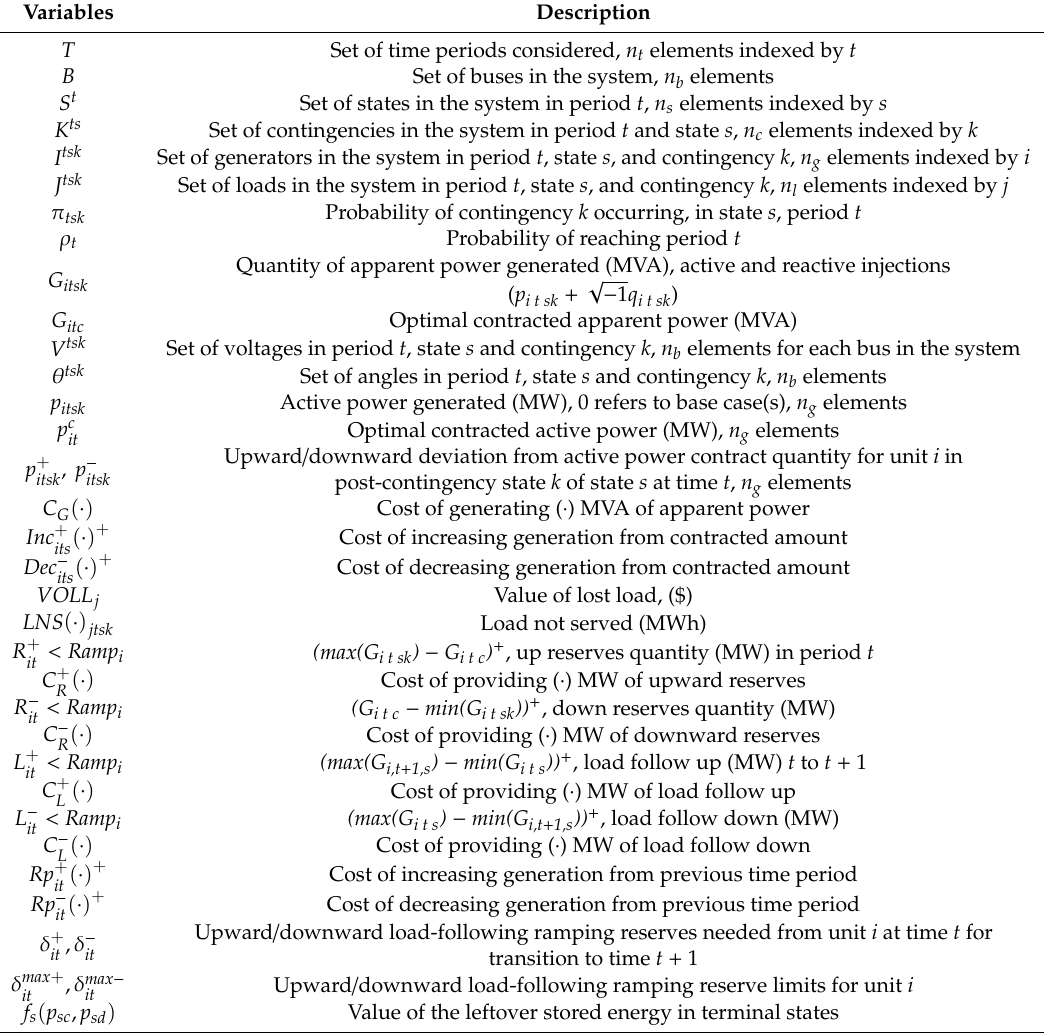
Table A1. Definition of variables in multi-period security constraint optimal power flow (MPSOPF).